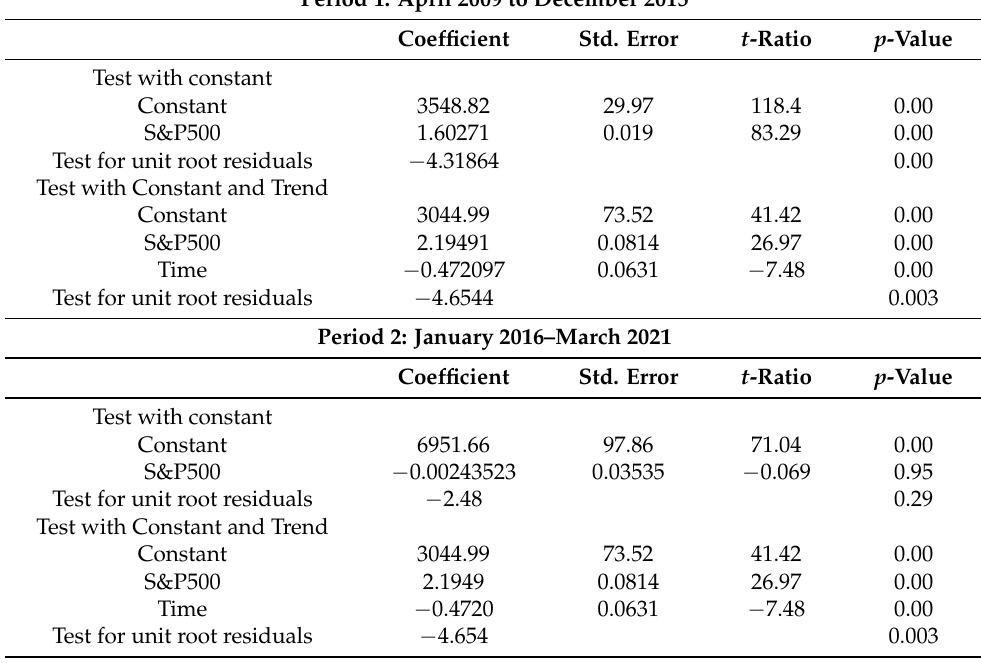
Table 3. Engle–Granger Tests of